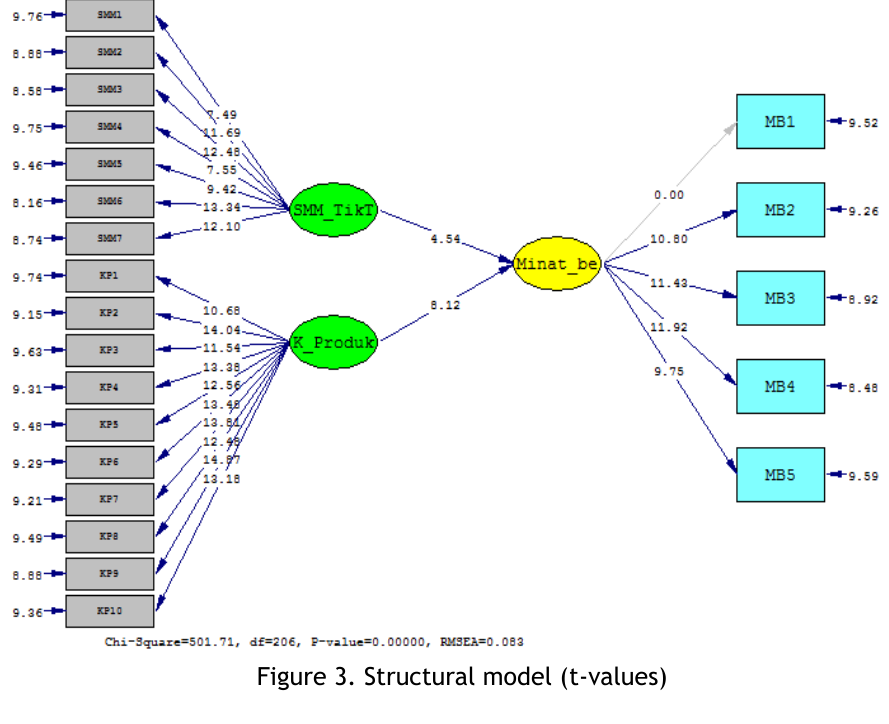
Figure 3. Structural model